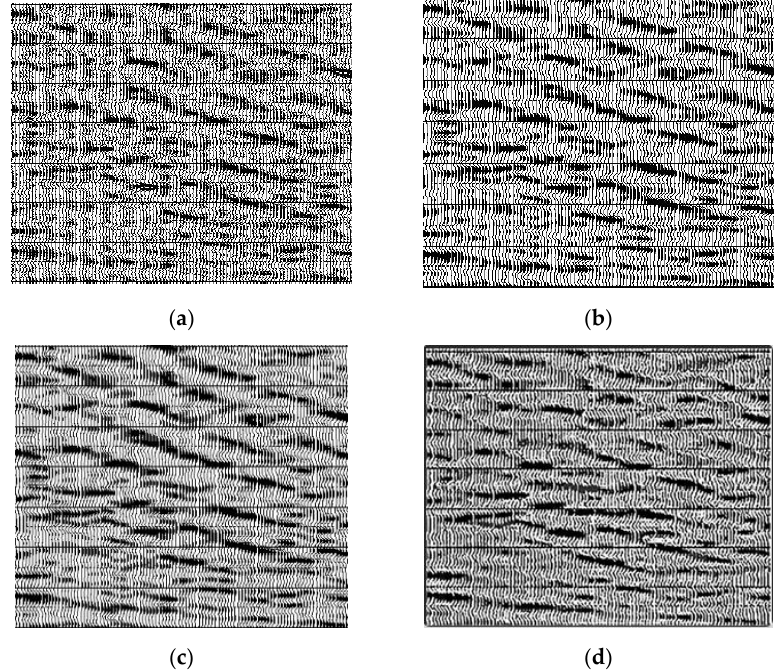
Figure 12. The comparison among different processing method; ( a ) original seismic data; ( b ) the seismic data processed by the wavelet transform; ( c ) the seismic data processed by the curvelet transform; ( d ) the seismic data processed by our method. Sensors 2020 , 20 , x FOR PEER REVIEW